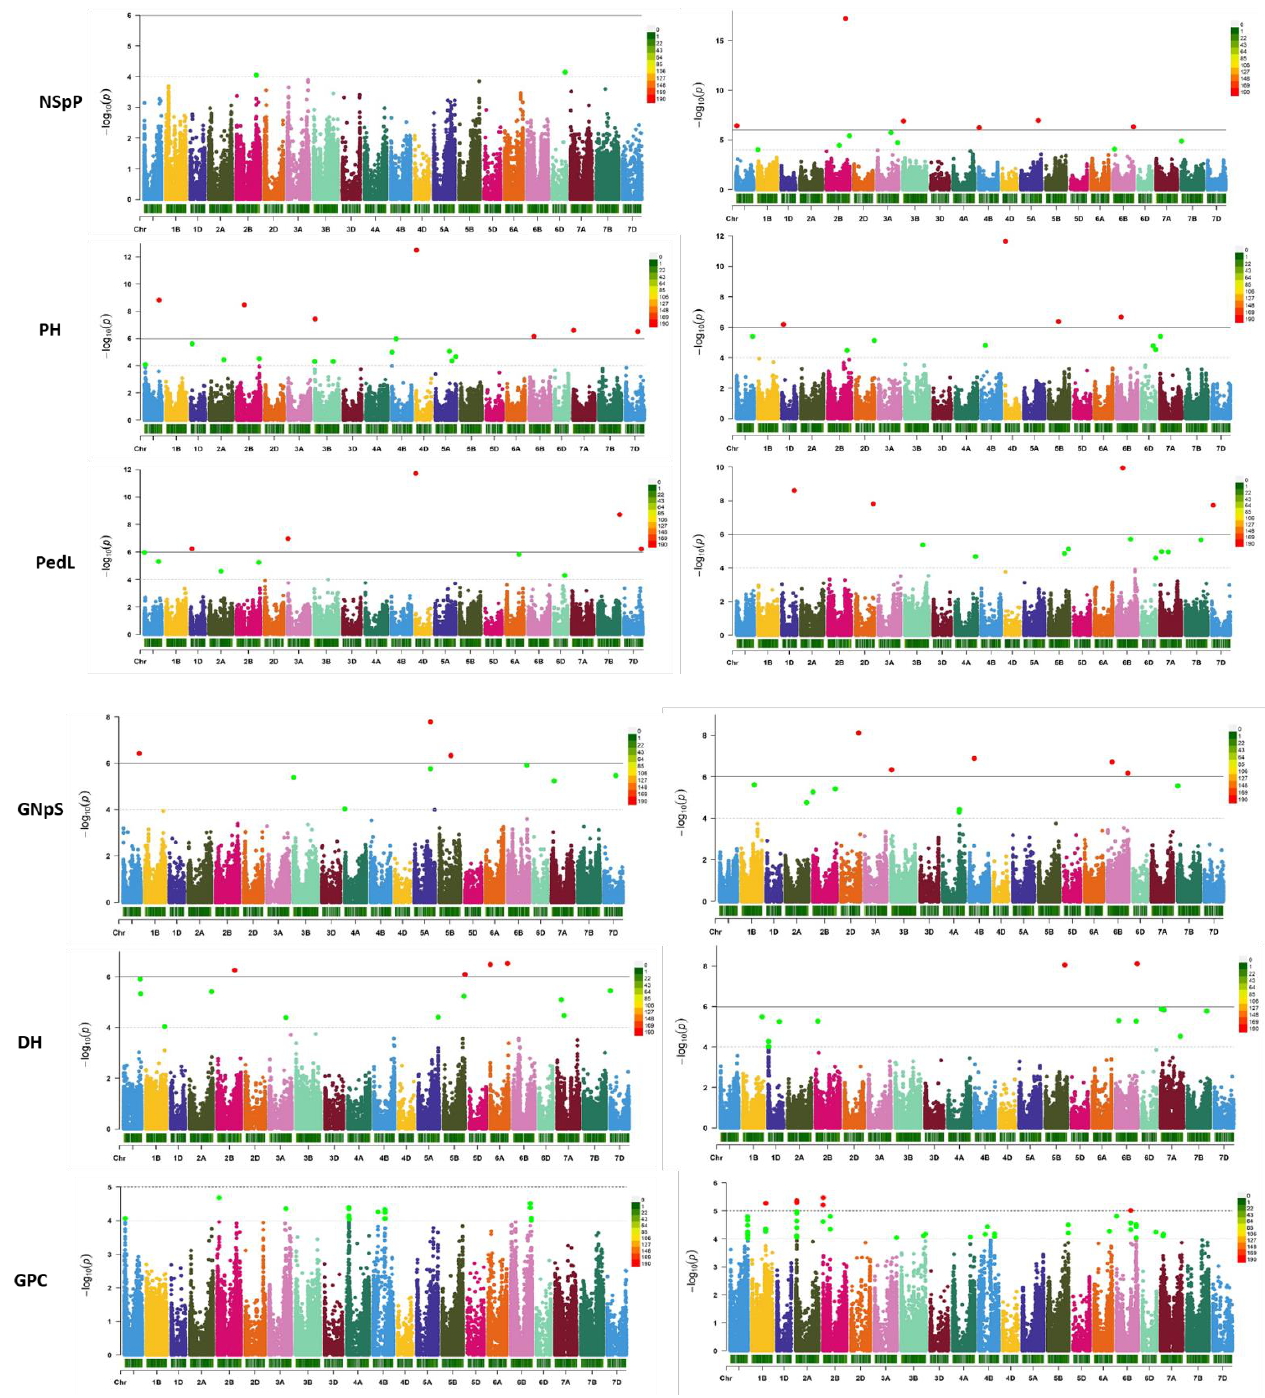
Figure 9. Manhattan Plots across all 21 wheat chromosomes, for nine traits: GY—Grain yield; SW— spike weight; GWpS—grain weight per spike; NSpP—number of spikes per plot; PH—plant height; PedL—peduncle length; GNpS—grain number per spike; DH—days to heading; GPC—grain protein content. SW, GNpS, GWpS, NSpP, PH, PedL, DH (FDR < 0.05), and GPC (FDR < 0.1). The ( a ) well-watered (W), and ( b ) water-limited (D) conditions. The FarmCPU model was used for GY, SW, GNpS, GWpS, NSpP, PH, PedL, DH, and the GLM model for GPC. The two horizontal lines indicate 10 −4 and 10 −6 thresholds of significance. The x -axis located 21 chromosomes in wheat. The y -axis located p -values (-log transformed).